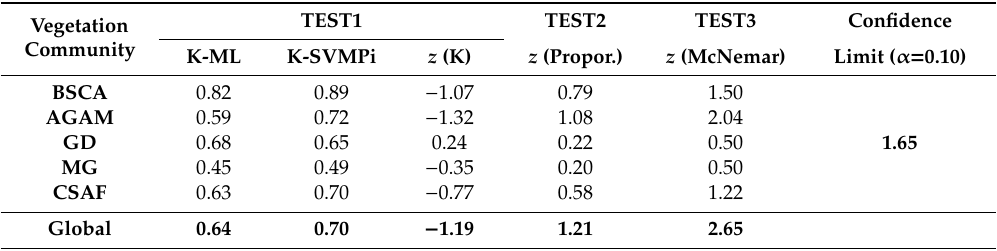
Table 5. Test results for the pixel-based classification, as a comparison of ML and SVMPi. For abbreviations, see main text.